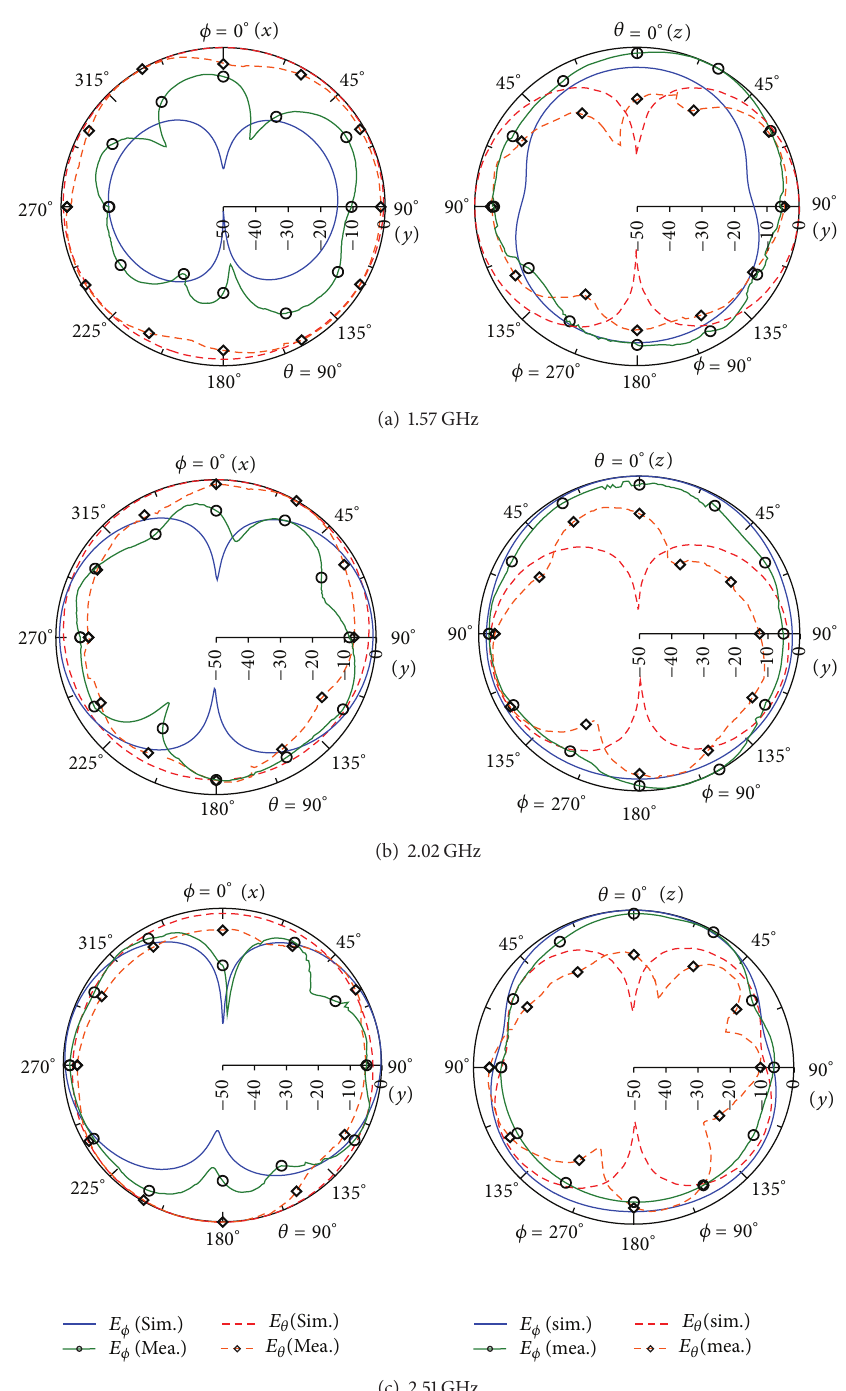
Figure 6: Comparison of the simulated and measured radiation patterns of the proposed antenna in the 𝑥𝑧 and 𝑦𝑧 planes at (a) 1.57 GHz, (b) 2.02 GHz, and (c) 2.51